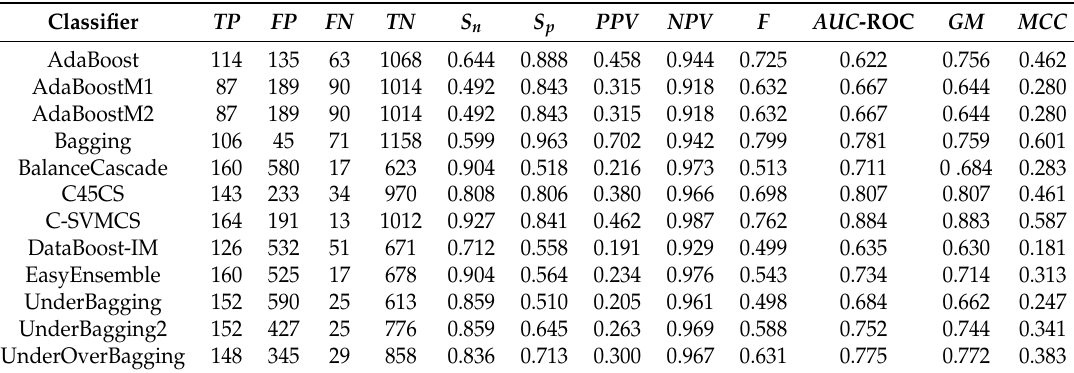
Table 2. Evaluation measures for each imbalanced classification algorithm.